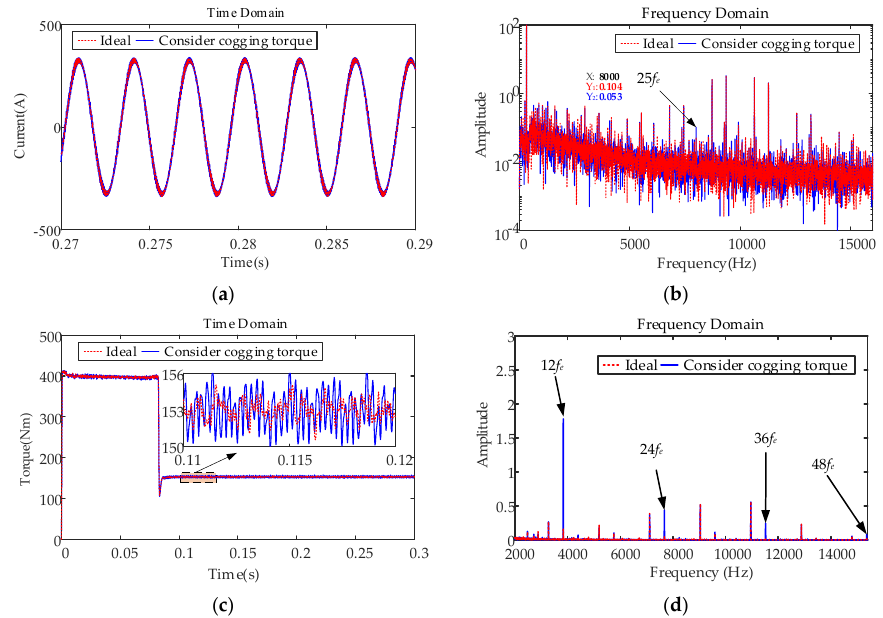
Figure 17. Comparison results of current and electromagnetic torque: ( a ) time domain of A ‐ phase current; ( b ) frequency domain of A ‐ phase current; ( c ) time domain of electromagnetic torque; ( d ) frequency domain of electromagnetic torque.